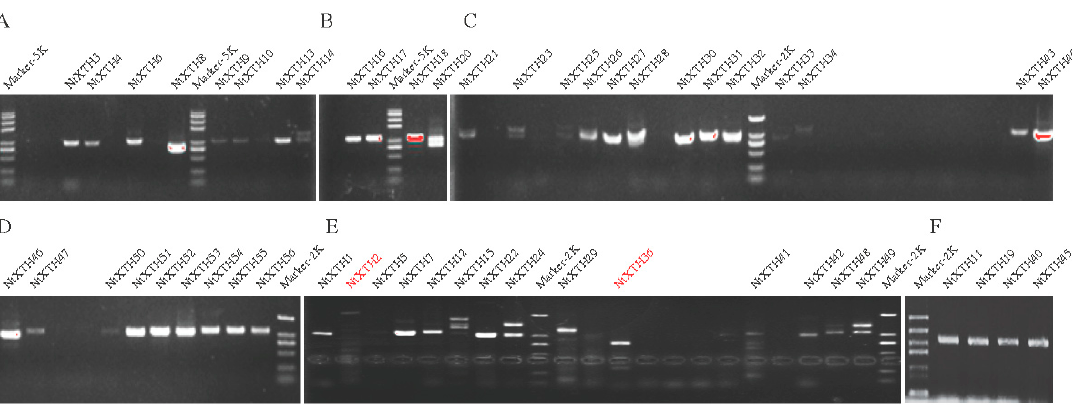
Figure 5. Amplification of cDNA fragments of the NtXTHs -. ( A – E ) Different rounds to amplify cDNA fragments of NtXTH genes. ( F ) Electrophoresis of four NtXTHs , which were used to study the subcellular localization.